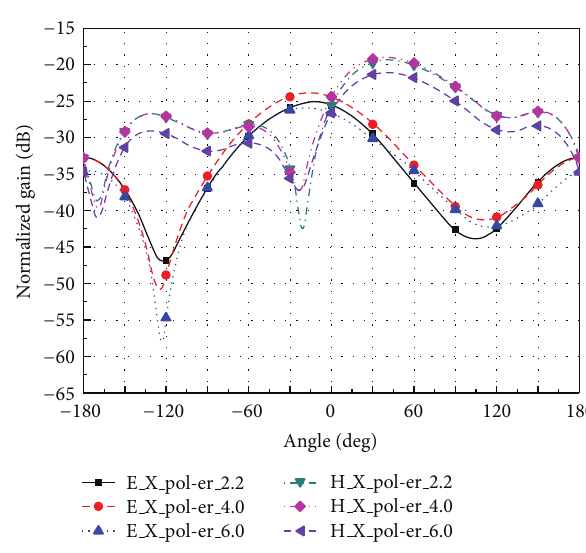
Figure 4: Cross-polarization radiation pattern of the conventional PDA and modified model at 10GHz. Figure 5: Cross-polarization pattern with different relative permit-